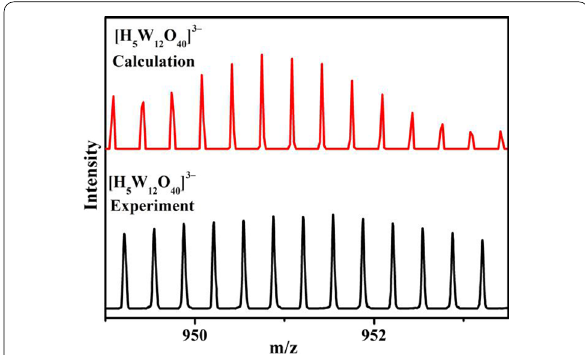
Fig. 12 Negative mode ESI-MS spectra of CeCdW 12 nanoflowers in distilled water in the range of 949–953.5 m/z